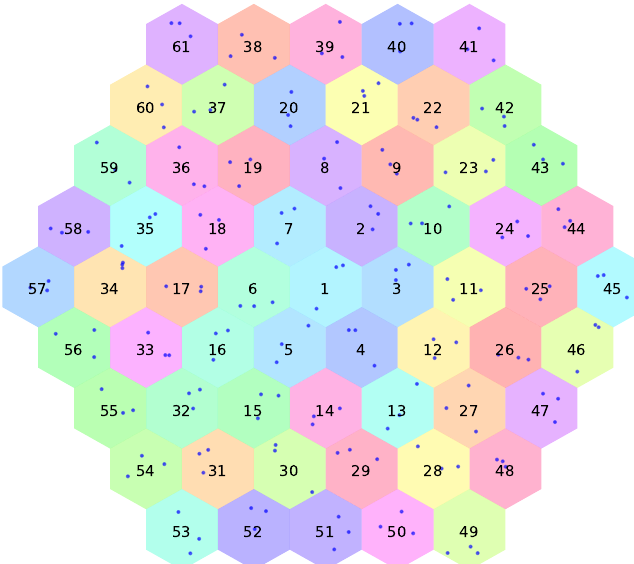
Figure 4. The proposed simulated UWSN with 61 base stations.